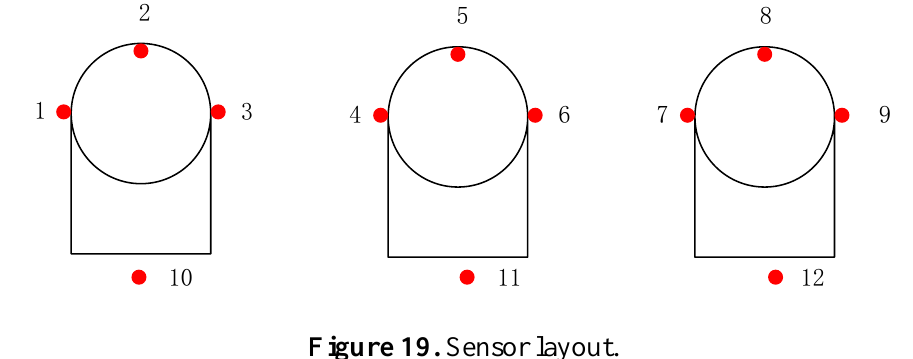
Figure 19. Sensor